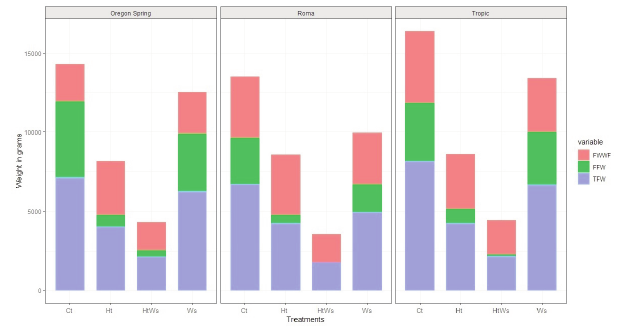
Tropic)Fig. 7 ­ Fruit yield (marketable harvested fresh fruit) and aerial biomass accumulation response for the three tomato varieties (Oregon Spring, Roma and Tropic). The treat­ ments consist of Control (Ct), Water stress (Ws), Heat + Water stress (HtWs) and Heat (Ht). Measured during the termination of experiment (i.e. after allowing for five weeks’ recovery from the treatments). FWWF=Fresh Biomass weight without fruits; FFW=Fresh fruits weights; TFW= Total fresh biomass